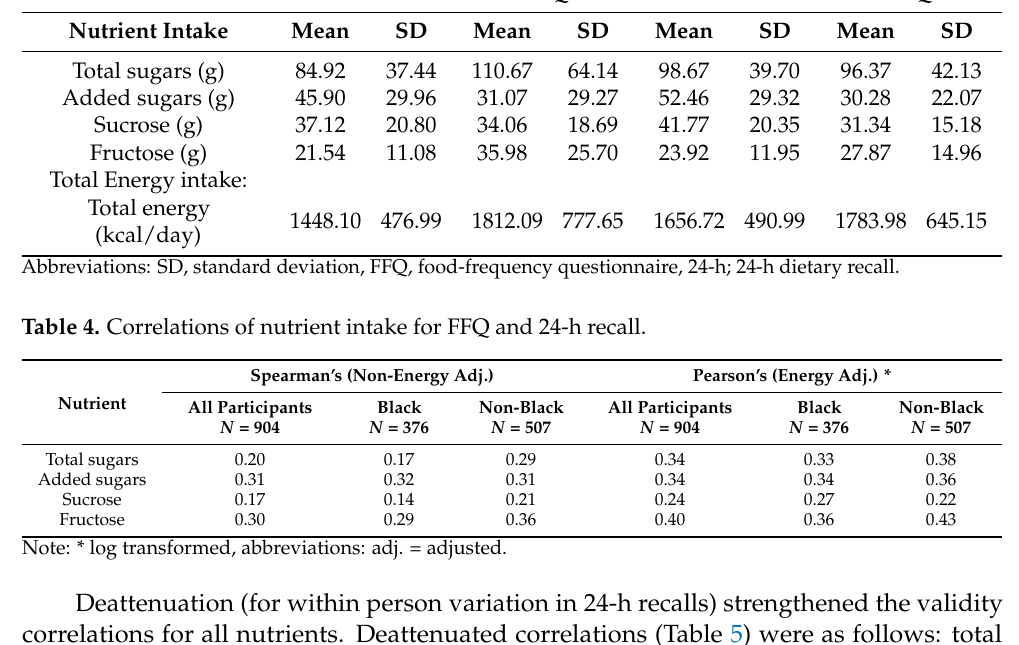
Table 5. Uncorrected and deattenuated energy-adjusted correlations of FFQ and 24-h recalls in all subjects and by race. All Nutrient Uncorrected N = 862 Total sugars (g)